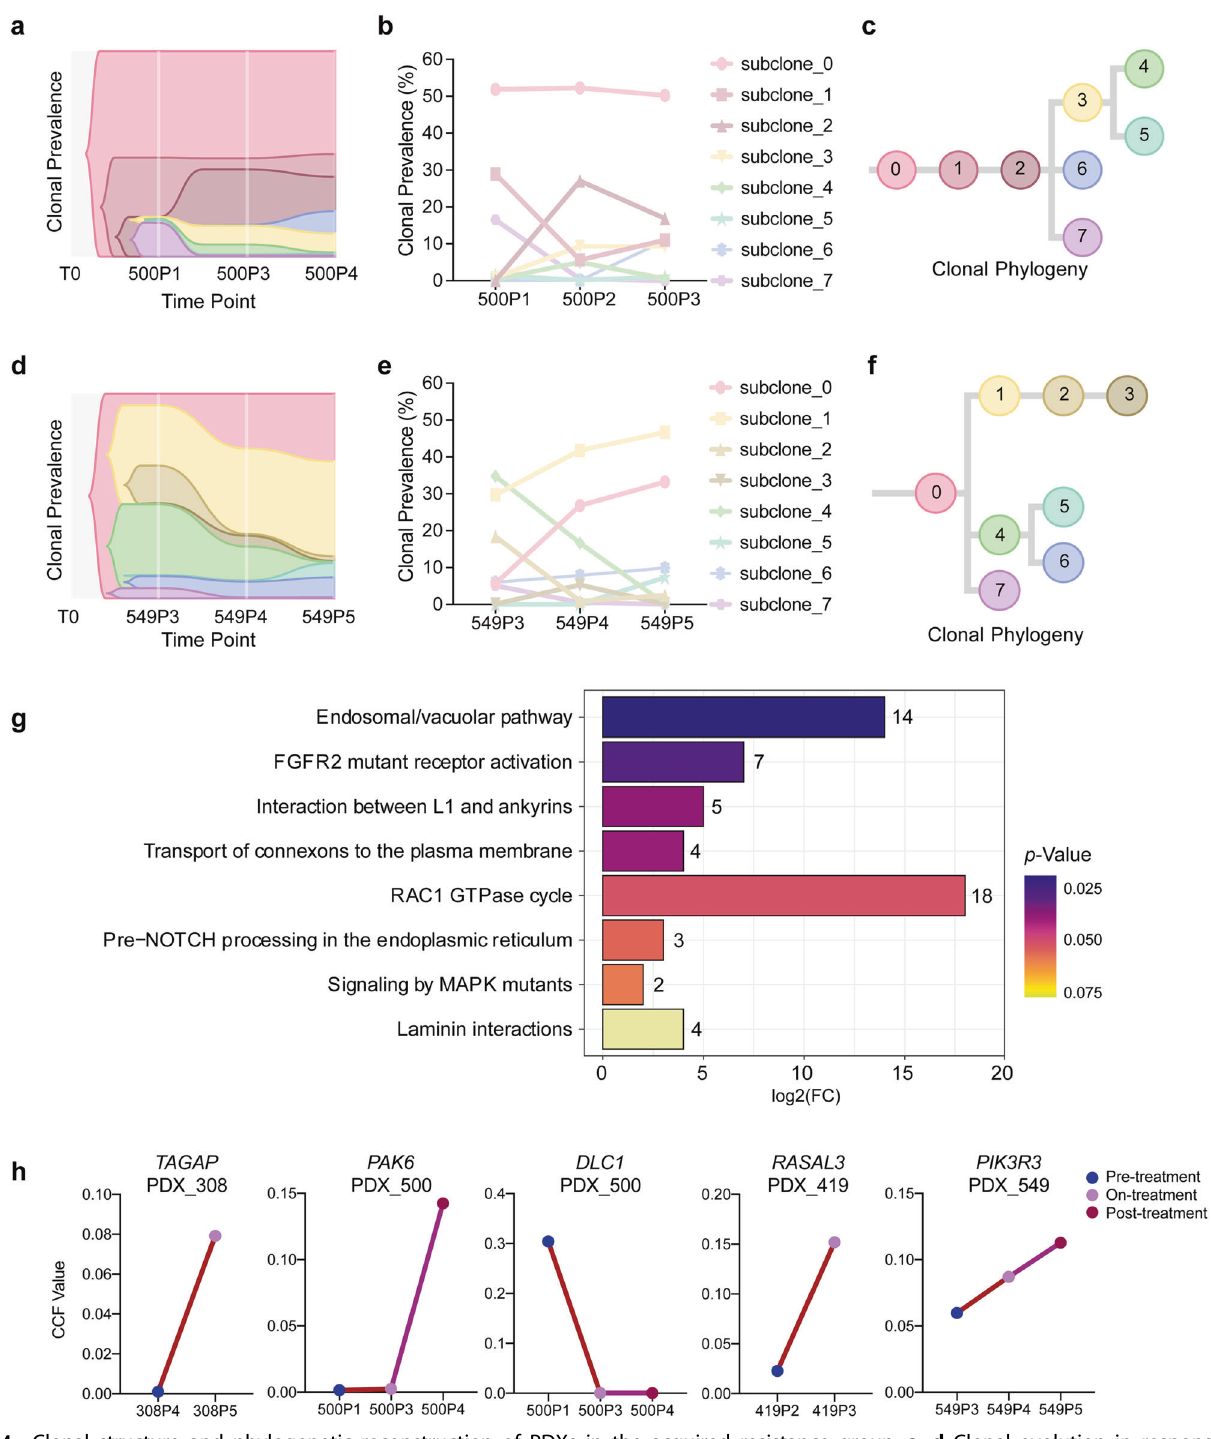
Fig. 4 Clonal structure and phylogenetic reconstruction of PDXs in the acquired resistance group. a , d Clonal evolution in response to cetuximab treatment inferred from WES sequencing. Plots of clonal lineages and frequency changes over time and in response to cetuximab treatment for two cases (PDX_500 and PDX_549). b , e The cellular prevalence of mutation clusters across PDX samples identi fi ed by PyClone analysis. The founding clone is indicated in light red as subclone_0, with subsequent subclones shown in distinct colors. The line graphs show the clonal prevalence of each subclone in multiple samples from the same case (corresponding to the area of the phylogenetic trees). c , f Phylogenetic trees constructed based on the mutation clusters for PDX_500 ( a ) and PDX_549 ( d ) in the acquired resistance group. g Analysis of signi fi cantly differentially enriched pathways in newly generated subclones in the acquired resistance group. h The line graphs illustrate changes in the CCF value of gene mutations ( TAGAP, PAK6, DLC1, RASAL3, PIK3R3 ) through cetuximab treatment in acquired resistance group